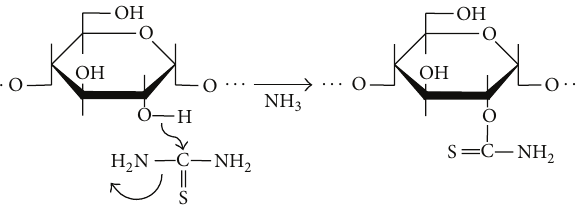
Figure 7: Proposed scheme for reaction of starch with urea.